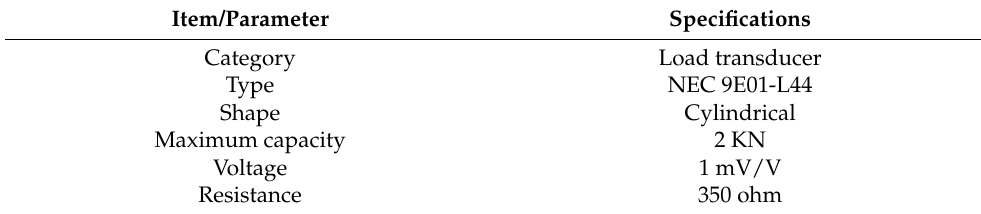
Table 3. Specifications of the force sensor.